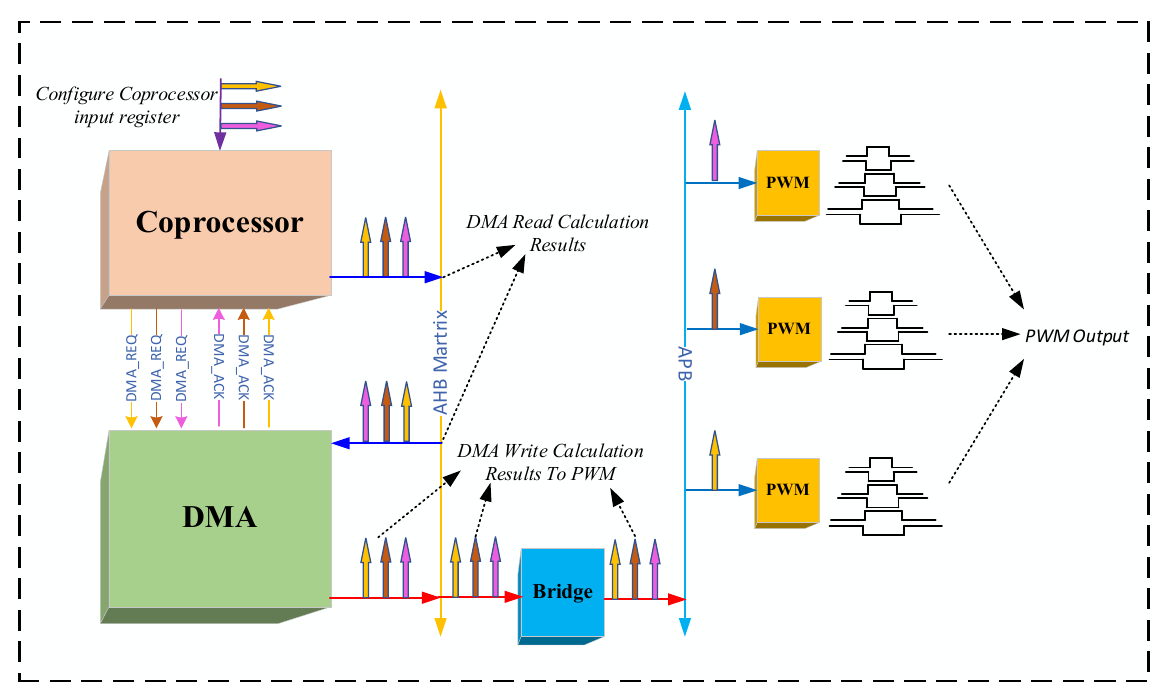
Figure 14. Coprocessor IP control timing sequence.